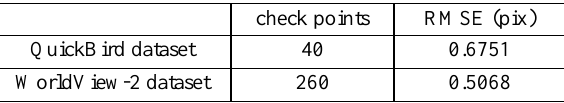
Table 2. RMSE of